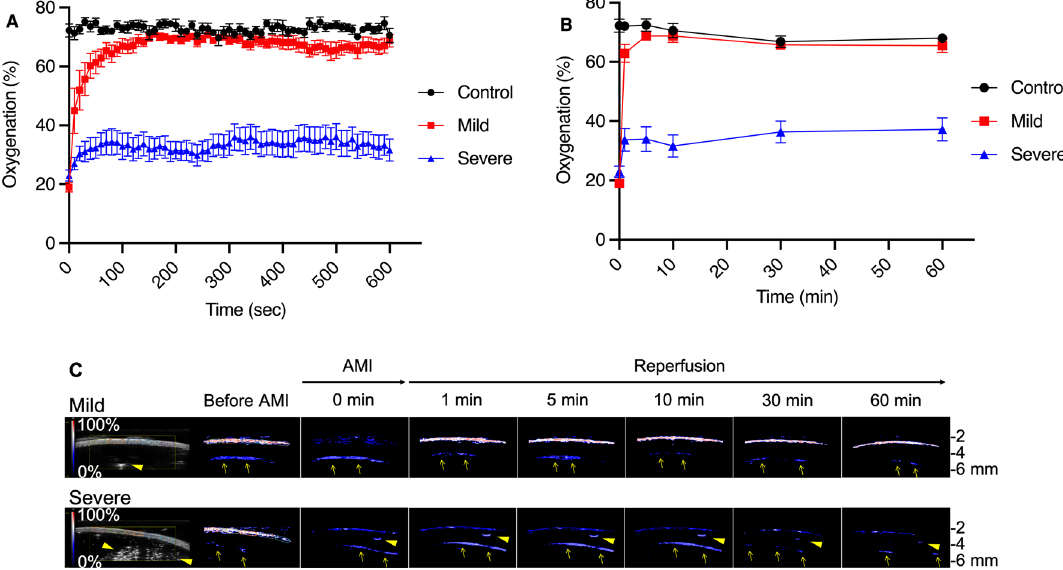
Figure 3. ( A ) Time course of mean oxygenation of the three groups until 10 min after reperfusion. The mild AMI group shows rapid recovery of oxygenation to the baseline within one minute, whereas the severe AMI group shows insufficient recovery. Note: Error bars represent standard errors of the mean (n = 10 rats per group). ( B ) Time course of mean oxygenation of the three groups until 60 min after reperfusion. Oxygenation of the mild group was significantly higher than that of the severe group at 1, 5, 10, 30, and 60 min after reperfusion. Note: Error bars represent standard errors of the mean (n = 10 rats per group). ( C ) Photoacoustic imaging of the proximal wall of the distal ileum before inducing AMI, before and 1, 5, 10, 30, and 60 min after reperfusion by removing vascular clamps in the mild and severe groups. B-mode image and oxygenation mapping of the mild and severe groups are shown on the left side. The oxygenation ranges from 0% (dark blue) to 100% (red). In both groups, oxygenation mapping shows equally high oxygenation at baseline (before AMI), and equally low oxygenation after a predetermined duration of AMI (30 min in the mild group and 180 min in the severe group). In the mild group, oxygenation clearly recovers 1 min after reperfusion. On the other hand, in the severe group, oxygenation does not apparently recover 1 min after reperfusion, and does not recover even after 60 min. Five adjacent regions of interest are placed on the proximal wall (shown on B-mode images). Arrows show reverberation artifact from the proximal wall, and arrowheads show reverberation artifact from air bubbles within ultrasound gel on the bowel surface. Note: AMI, acute mesenteric ischemia; Mild, the mild group; Severe, the severe group; Before AMI, baseline; 0 min, after a predetermined duration of AMI (30 min in the mild group, 180 min in the severe group) and just before reperfusion (removing vascular clamps); 1 min, 1 min after reperfusion (removing vascular clamps); 5 min, 5 min after reperfusion; 10 min, 10 min after reperfusion; 30 min, 30 min after reperfusion; 60 min, 60 min after reperfusion; numbers shown on the right side indicate the depth. ( D ) Linear regression of oxygenation at 0, 1, 5, 10, 30, and 60 min after reperfusion against the pathological score of the mild and severe groups (total 20 rats). At all time points after reperfusion, there is a strong negative linear relationship between oxygenation and the pathological score. The correlation coefficient at 1 min after reperfusion is already comparable to those at other time points. The correlation coefficient (r s ) and P -values are shown on the upper right corner of each figure. Spearman’s test was used for